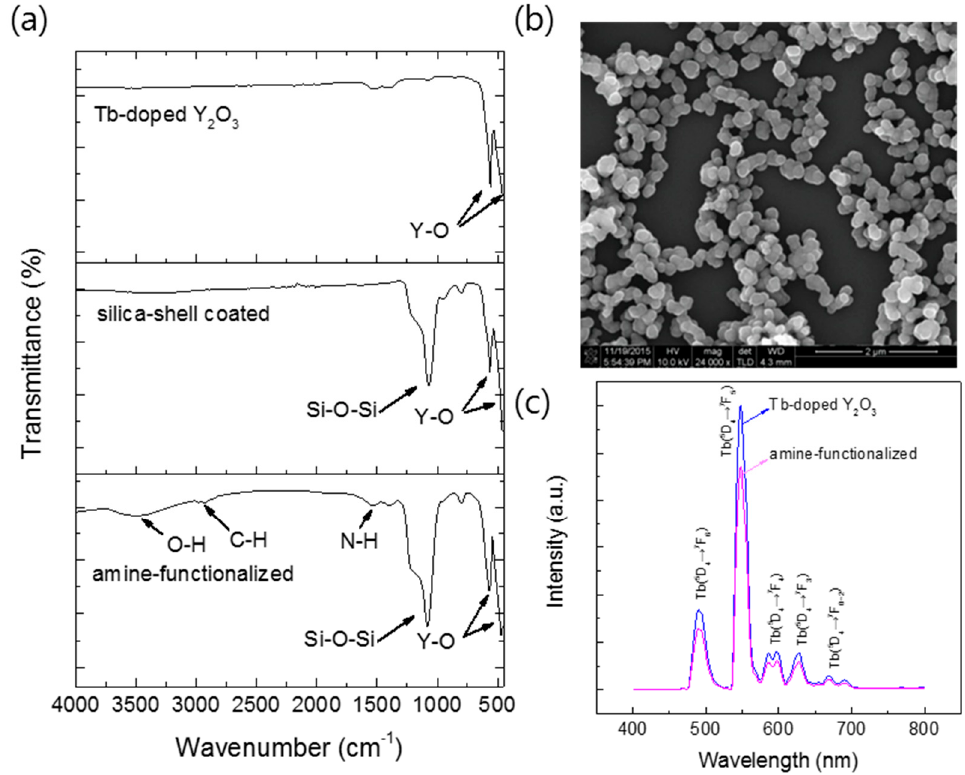
Figure 10. ( a ) Fourier transform infrared (FT-IR) transmittance spectra of Y 2 O 3 :Tb 3+ nanoparticles